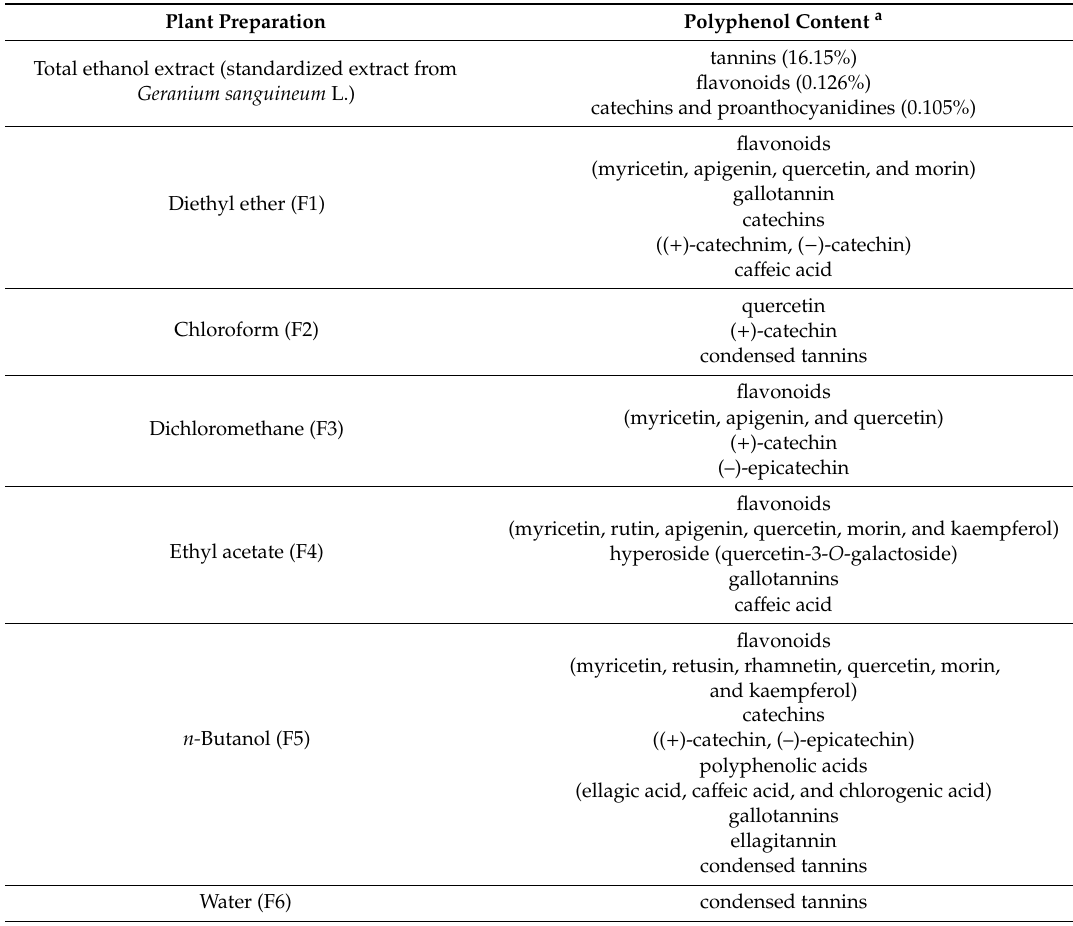
Table 1. Polyphenol content of the total ethanol extract isolated from Geranium sanguineum L. and its fractions. Plant Preparation Polyphenol Content a Total ethanol extract (standardized extract from Geranium sanguineum